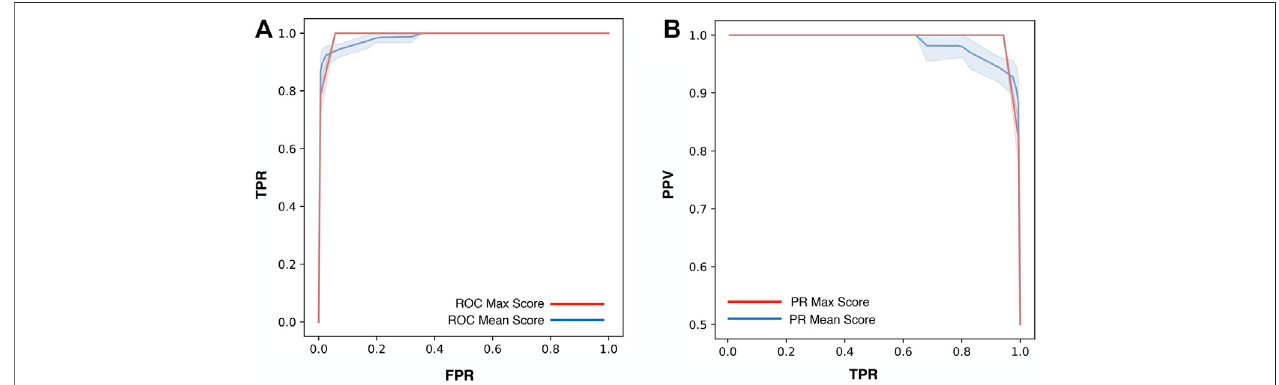
FIGURE 2 | Performance measures of ThermoScan based on the Max (red) and Mean (blue) scores. The plots show the AUC (Area Under the receiving operating characteristic Curve). The shaded area represents the range between the minimum and maximum scoring values (A) and the AUPR (Area Under the Precision-Recall curve) (B) for the two scoring systems. The TPR, FPR, and PPV performance measures are de fi ned in Supplementary Materials .